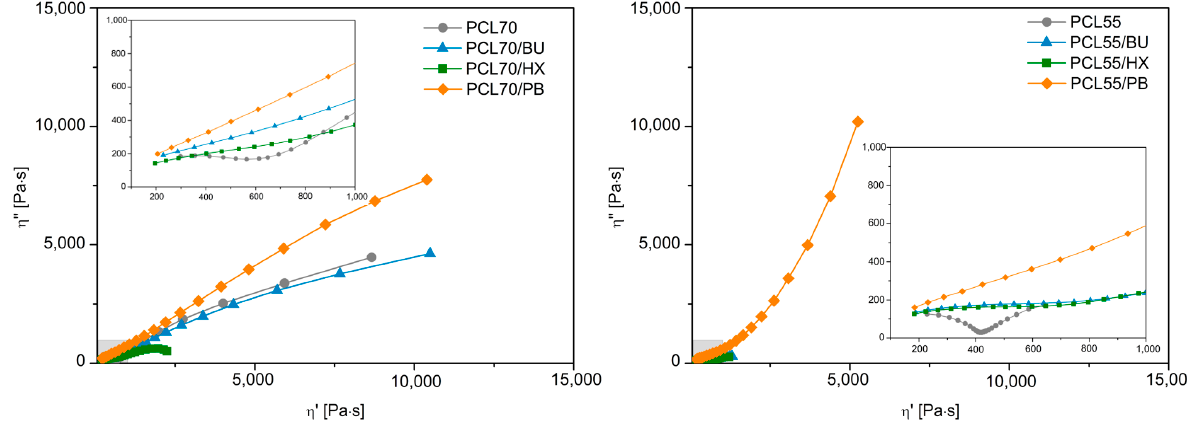
Figure 8. Cole–Cole plots for PCL/PLA blends at various weight ratios ((70/30) and (55/45)) and modified by OP.